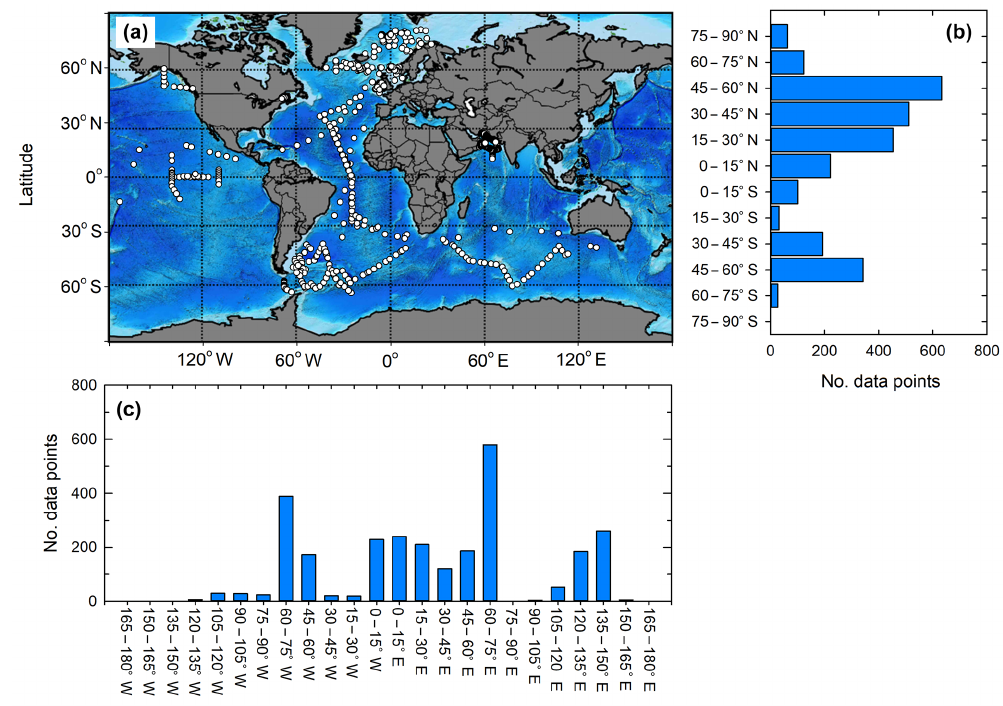
Figure 1. Global map of CaCO 3 production data (a) and the frequency of data by latitude (b) and longitude (c) . Global map in (a) superim- posed on ocean